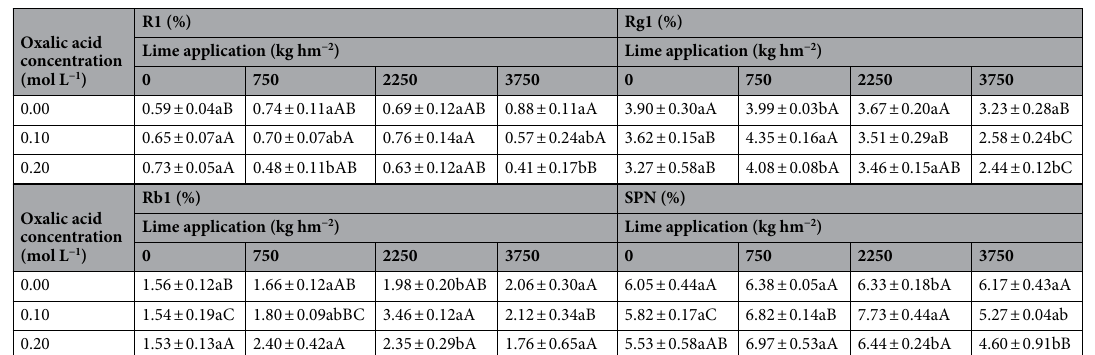
Table 4. Effects of foliar oxalate application on the percentages of three saponins in roots of Panax notoginseng under Cd stress. Date were means ± SD. The same saponin with different lowercase letters and the same amount of lime were significantly different between the treatments ( P < 0.05), and the same saponin with the same uppercase letter indicated that there were significant differences between the treatments under the same oxalic acid ( P <